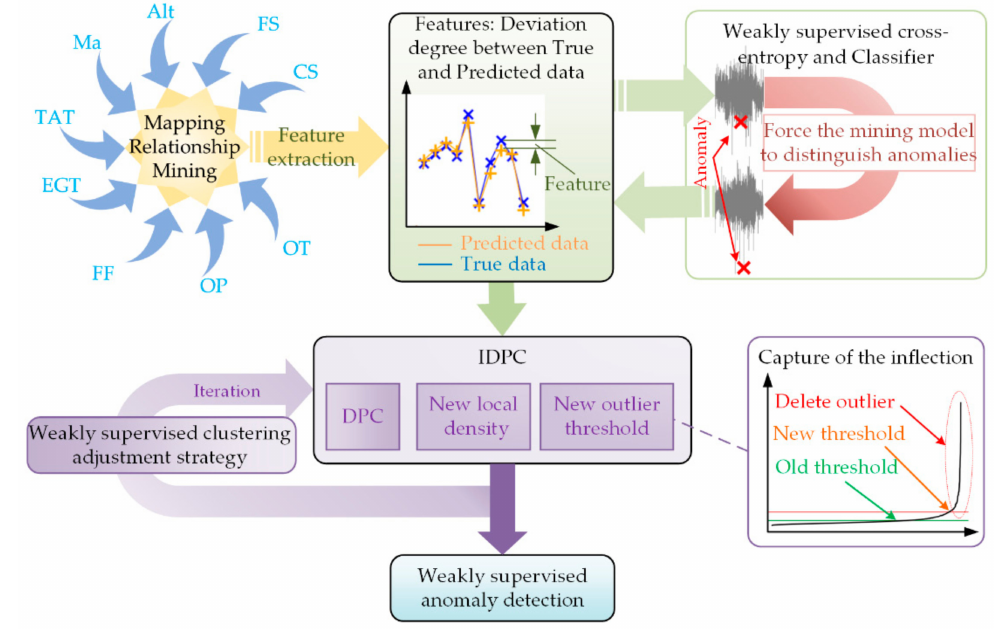
Figure 1. Proposed framework.